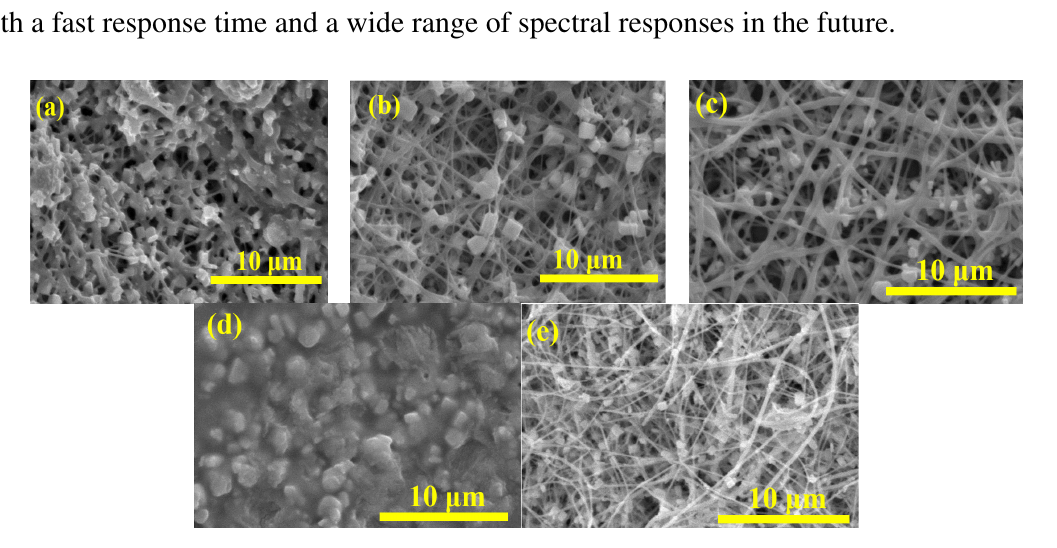
Figure 9. SEM images of MAPbI 3 /PVP composite fibers produced at different MAI/ isopropyl alcohol (IPA) concertaion/immersing time/IPA rinsing time: ( a ) 0.1 M/5 min/5 s; ( b ) 0.1 M/10 min/5 s; ( c ) 0.1 M/10 min/5 min; ( d ) 0.1 M/20 min/5 s and ( e ) 0.2 M/3 min/5 s.